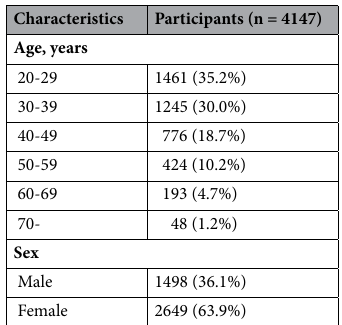
Table 1. Baseline characteristics of the study participants. Data are presented as n or n (%).